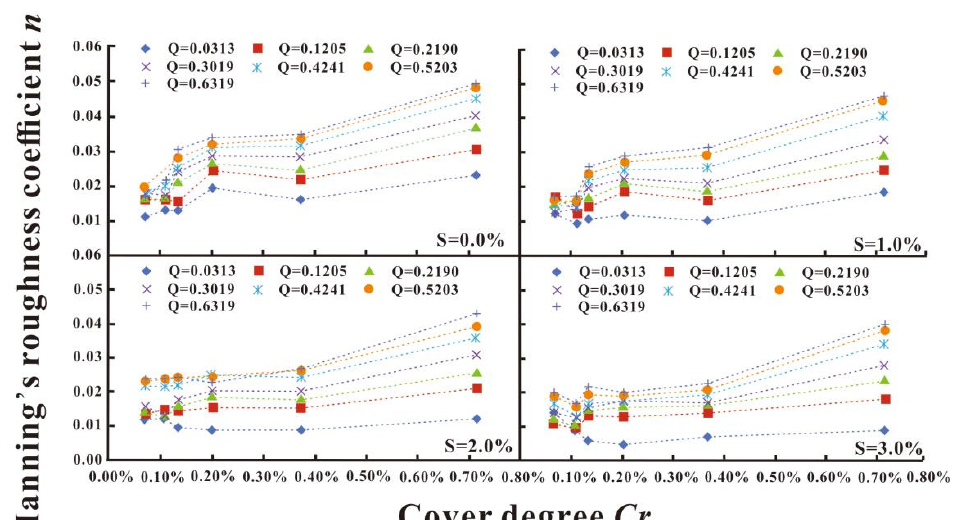
Figure 6. The relationship between Manning’s roughness coefficient ( n ) and stem cover ( Cr ) under different flow discharge ( Q ) and slope gradient ( S ) conditions. Stem cover range: 0.72, 0.37, 0.20, 0.13, 0.11, 0.07%; slope gradient range: 0, 1.0, 2.0, 3.0%; flow discharge range: 0.0313, 0.1205, 0.2190, 0.3019, 0.4241, 0.5203, 0.6319 m 3 /min.